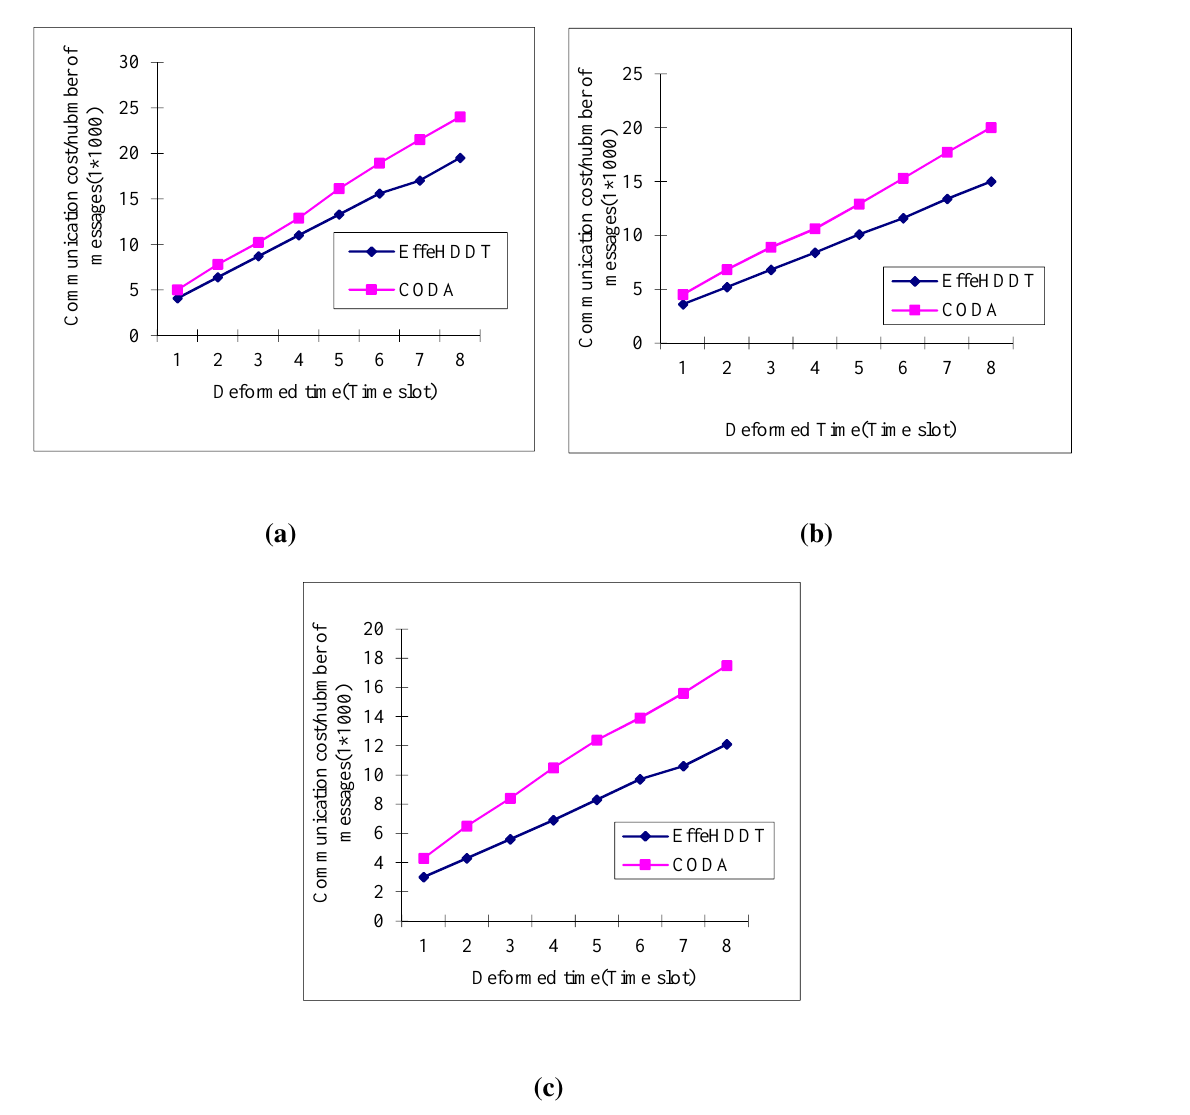
Figure 12. Communication cost over time with deformed speed. ( a ) EffeHDDT with 100 domains and CODA with 100 clusters; ( b ) EffeHDDT with 150 domains and CODA with 150 clusters; ( c ) EffeHDDT with 200 domains and CODA with 200